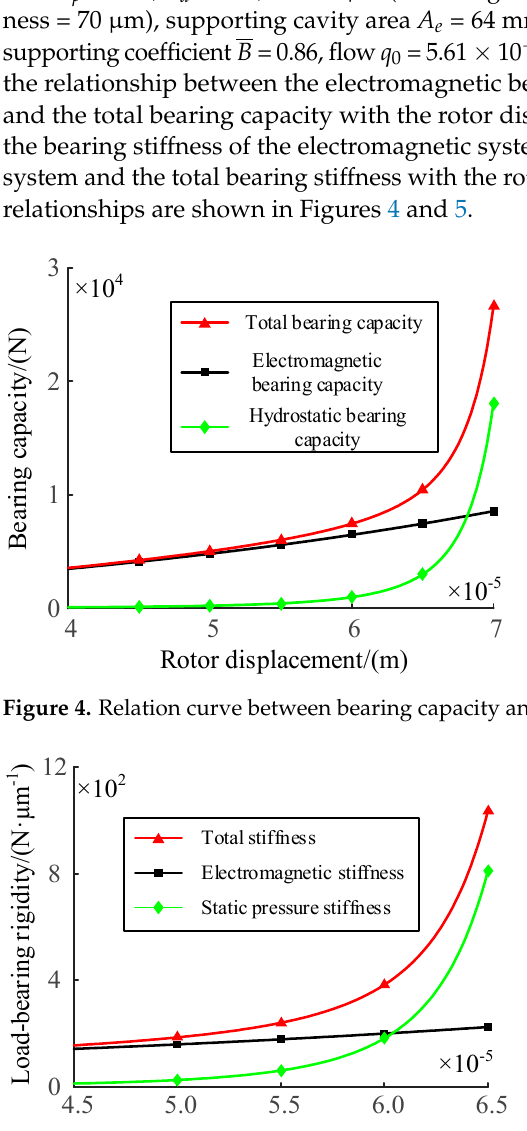
Figure 5. Relation curve between bearing stiffness and displacement Δ x .